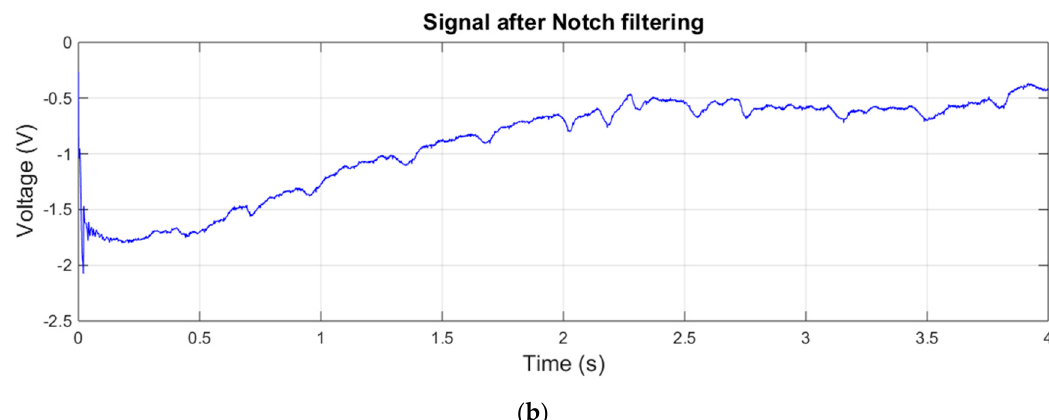
Figure 7. Physiological signal obtained while the mouse had one limb in contact with an EPIC sensor of the matrix: before ( a ) and after ( b ) the notch filter.